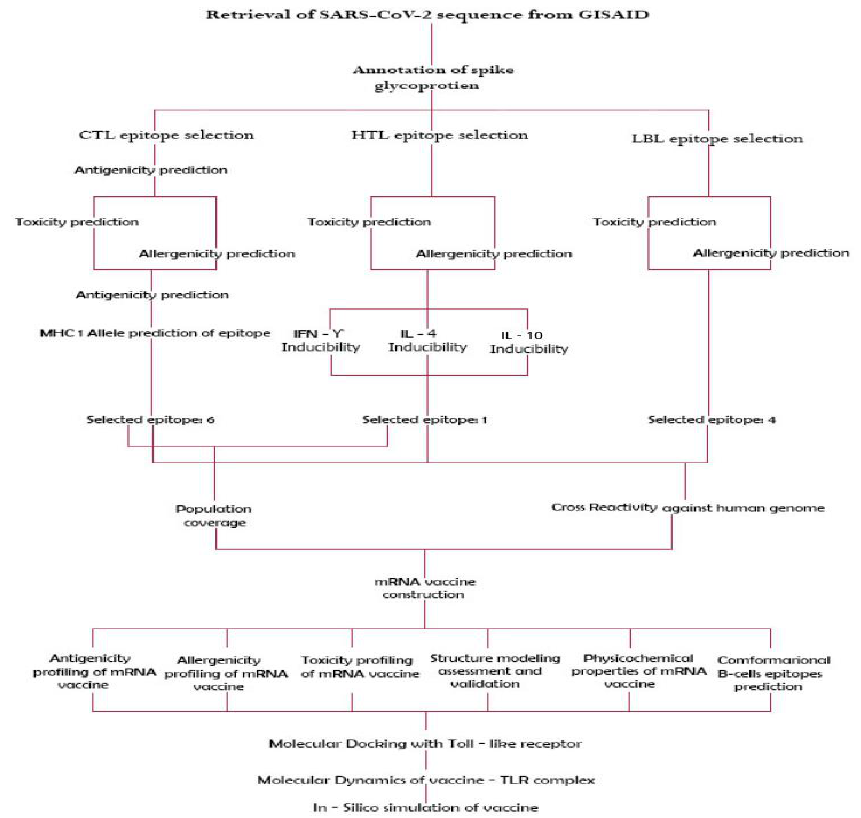
Figure 1. Workflow for the universal mRNA vaccine construct.